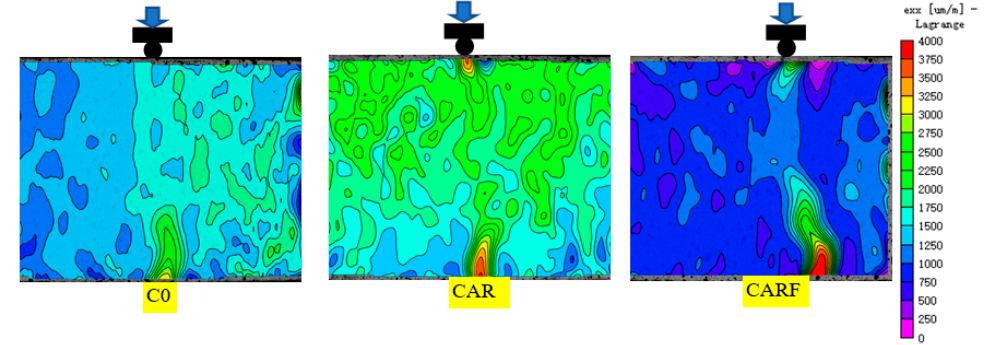
Figure 9. Strain fields under flexural loads of specimens incorporating toughening materials.